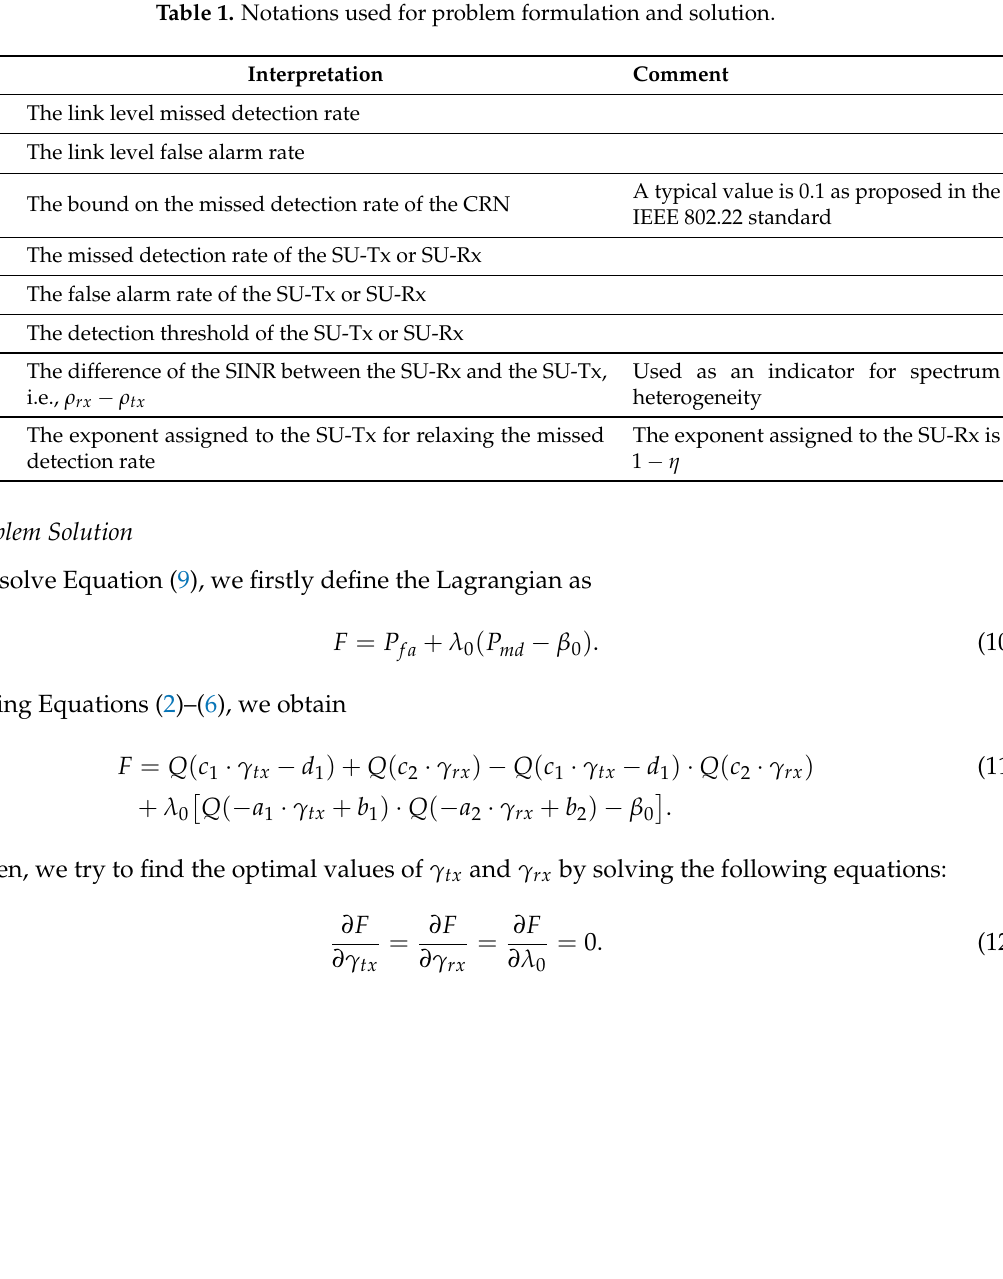
Table 1. Notations used for problem formulation and